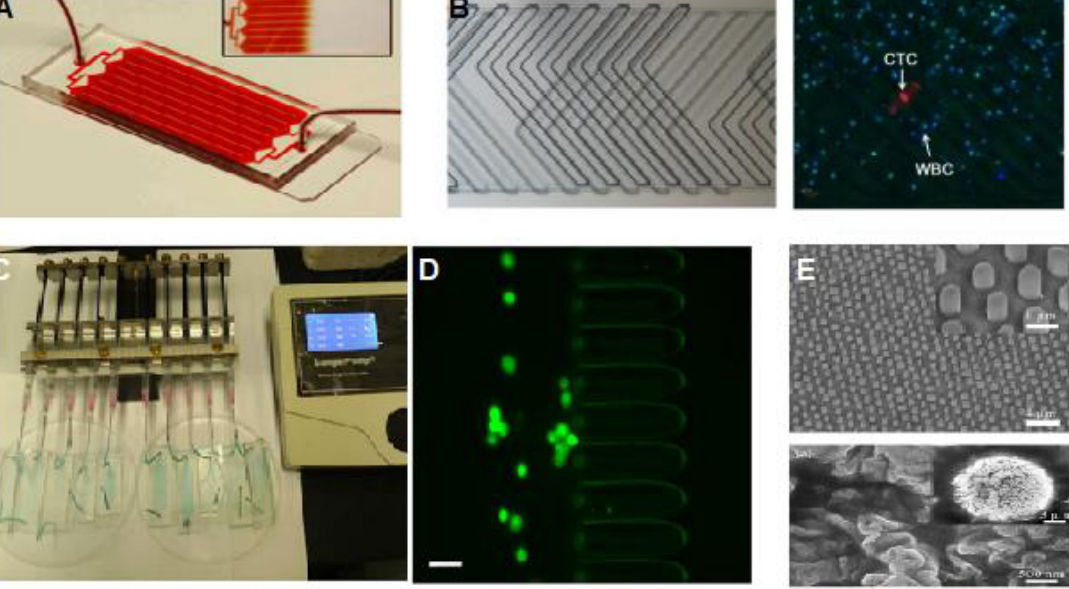
Figure 1. ( A ) The HB-Chip is composed by a collection of microfluidic channels with a single fluid entrance to multiple channels to move again to a single channel to exit, which allows uniform blood flow inside the device [35]. Copyright 2010 National Academy of Sciences. ( B ) Herringbone chip with microstructures in a double-sided channel. The chip was validated with real blood samples from lung cancer detection. CTCs were capture and stained inside the chip with antibodies against CK in red, DAPI in blue, and CD45 in green [36]. “Republished with permission of [Royal Society of Chemistry]; permission conveyed through Copyright Clearance Center, Inc. ( C ) Microfluidic platform for highly efficient retention of CTCs based on a physical variation on cell deformation and diameter. The chip is composed by micro-ellipse filters which were able to detect CTCs from the detection of colon, breast and non-small-cell lung (NSCLC) cancer [38]; Copyright © 2017, Springer Nature. ( D ) Tumor cells captured by a microfluidic platform for high capture efficiency of CTCs (Green), where the CTCs pass through the ellipse filters (Scale bar = 50 µm) [38]; Copyright © 2017, Springer Nature. ( E ) Nanopillar arrays with a diameter of 650 nm with cell membrane details of the capture cells into the device [39]; Copyright © 2017, Springer Nature. ( F ) OncoBean Chip with micropost structures inside the device. The device allows the cell separation by affinity at high flow rates, applying a radial flow, which produces a variation of the shear profile across the device. Licensed under CC BY-NC International License. The final, published version of this article is available at [41]. ( G ) Microfluidic device based on the separation of CTCs clusters by Size and Asymmetry. The device was tested with whole blood (red) and colored PBS buffer (blue) [42]; Copyright © 2017, Springer Nature. Apart from functionalizing the microfluidic channel with immunoreceptors, other strategies were focused on the modification of immunomagnetic beads with the same EpCAM antibodies, which flowed inside microfluidic channels, such as CellSearch ® . This platform is the standard method for CTC enrichment and is the only blood test accepted by the Food and Drug Administration (FDA) for detecting CTCs in patients with metastatic breast, prostate, and colorectal cancer [43,44].